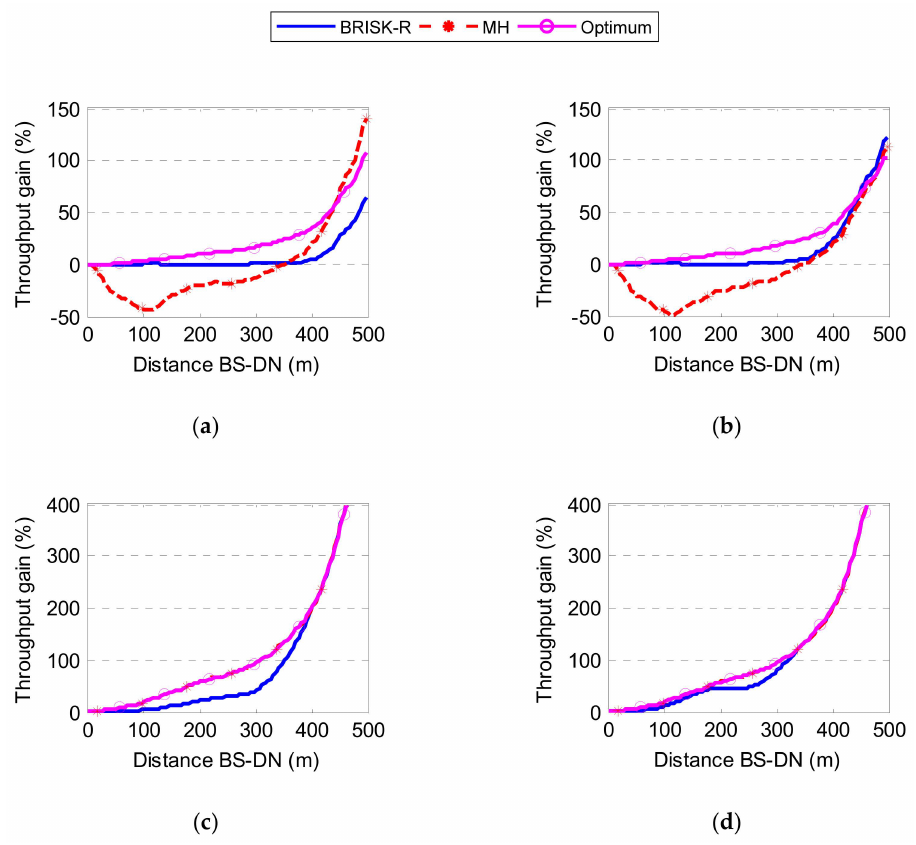
Figure 10. Throughput gain obtained with the mode selection schemes with respect to SH—mixed multimediatraffic&homogeneousscenario. ( a )Emailtransmissions—15RN;( b )Webtransmissions—15RN; ( c ) Email transmissions—1000 RN; ( d ) Web transmissions—1000